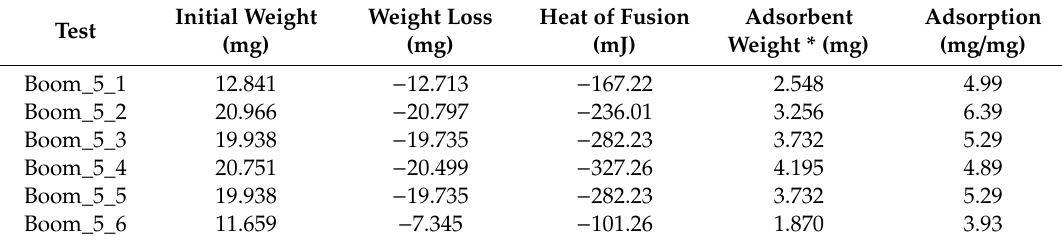
Table 5. TGA tests on Grafysorber ® samples from